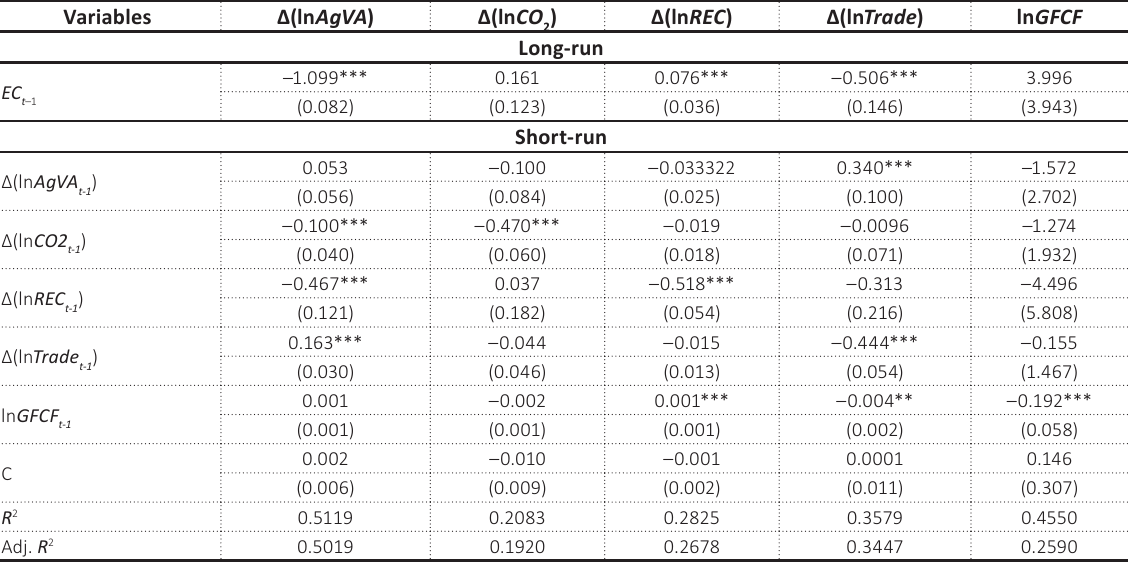
Table 7. Panel Vector Error Correction Model (PVCM) estimating long-run